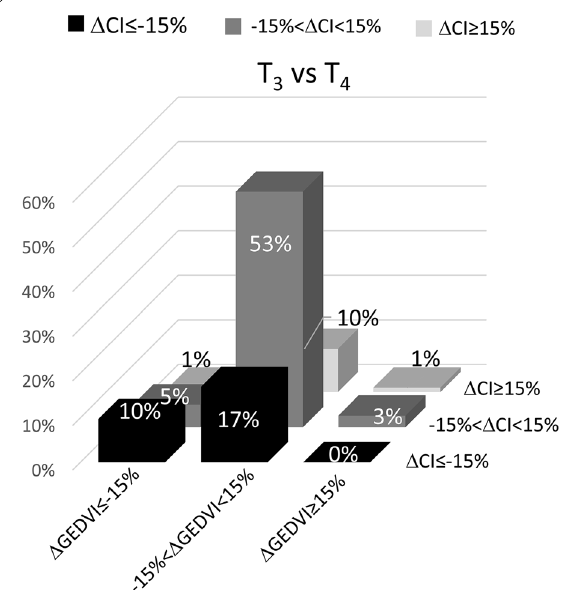
Fig. 4 Hemodynamic pattern as a function of ΔCI and GEDVI between T 3 and T 4 . Bars are percentage of patients falling in each category. CI, cardiac index; GEDVI, global end‑diastolic volume index; ΔCI, change in CI; ΔGEDVI, change in GEDVI; T 3 , end of prone position session;